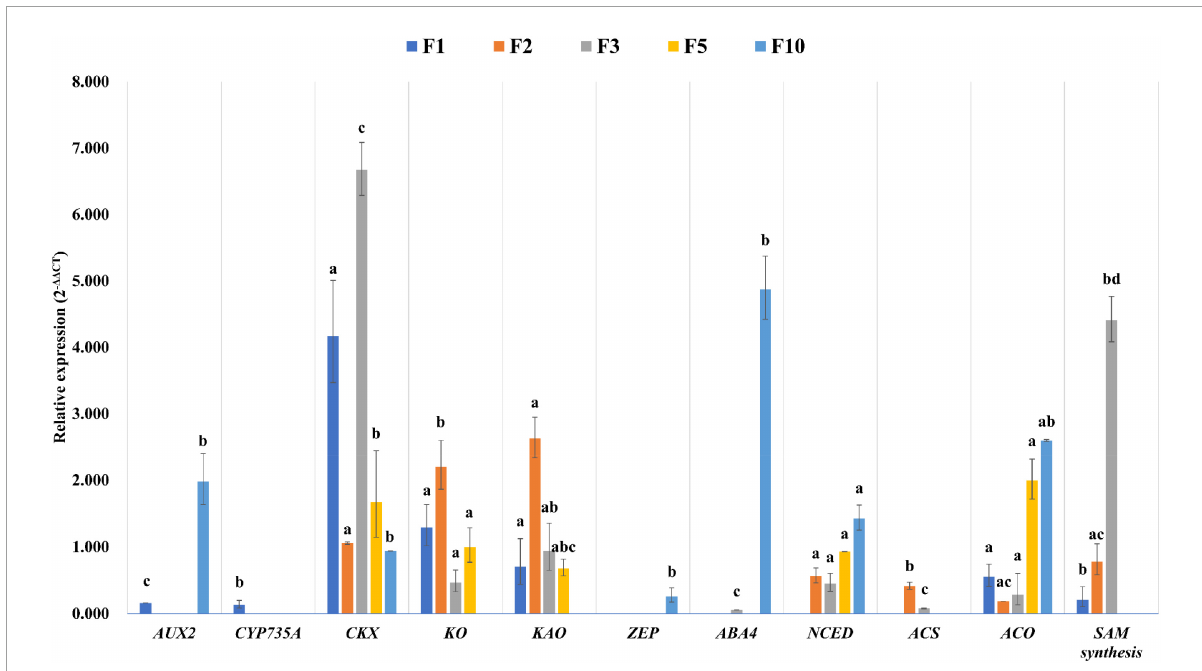
FIGURE8 Reverse transcription-quantitative polymerase chain reactions (RT-qPCR) results of eleven unigenes related to endogenous hormone synthesis pathway. Elongation factor (EF1- α ) gene was used as the reference gene for normalization of gene-expression data. All data are averages of three independent experiments, and error bars represent scanning electron microscopy (SEM). Bars with the same lowercase letters within a genotype indicate not significant differences by Fisher’s least significant difference test at p < 0.05.